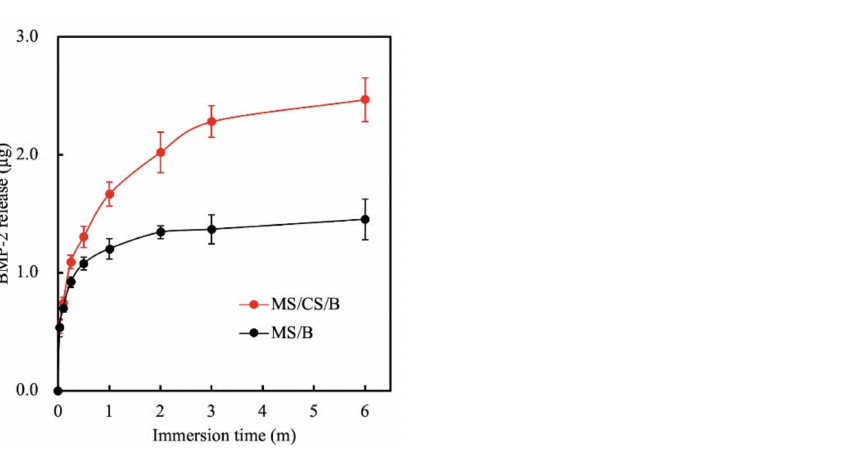
Figure 5. Bone morphogenetic protein-2 (BMP-2) release from an MS/CS/B and MS/B scaffold after immersion in Dulbecco’s modified Eagle’s medium (DMEM) at 37 ◦ C for 6 months.